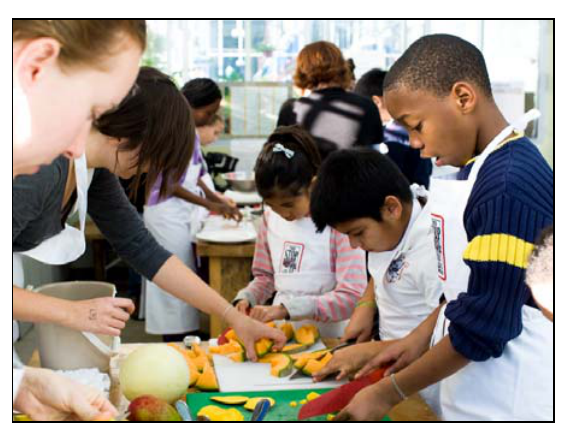
Figure 4: Community